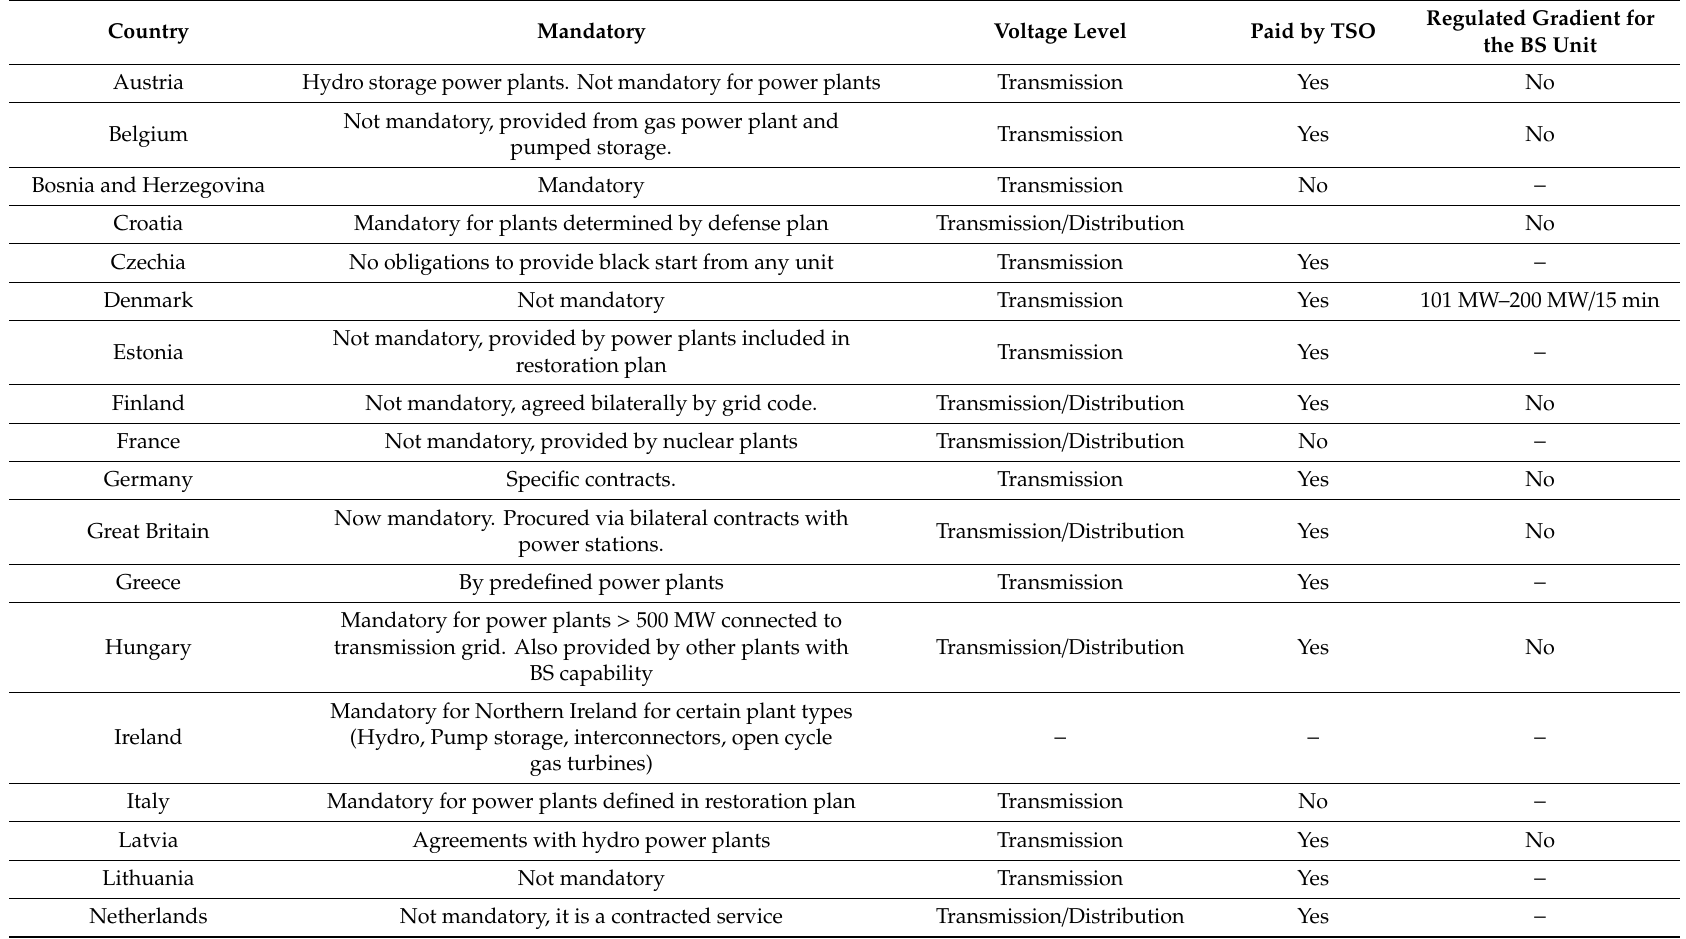
Table A3. Provision of black-start in various EU